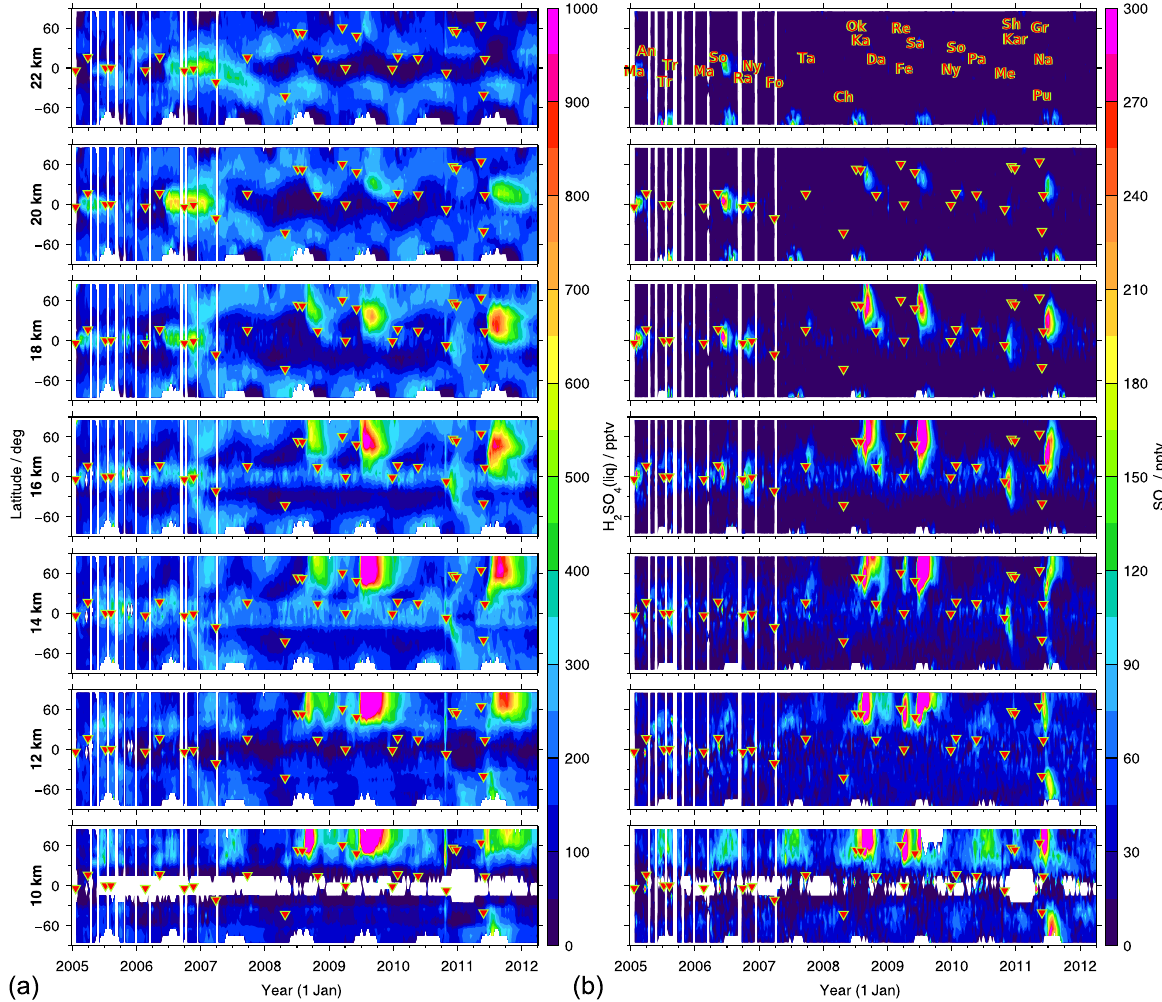
Figure 5. Global time series of latitudinally resolved distributions of MIPAS liquid-phase H 2 SO 4 (a) and SO 2 (b) volume mixing ratios. Shown are 8-day mean values for 10 ◦ latitude bins at different altitudes (10 to 22km). The colour code is restricted to 0–1000pptv for H 2 SO 4 (liq) and 0–300pptv for SO 2 . Values exceeding these limits are assigned the limiting value. Volcanic eruptions are indicated by red triangles (together with their abbreviations in the uppermost image of panel (b) ; following Höpfner et al., 2015). Abbreviations: An